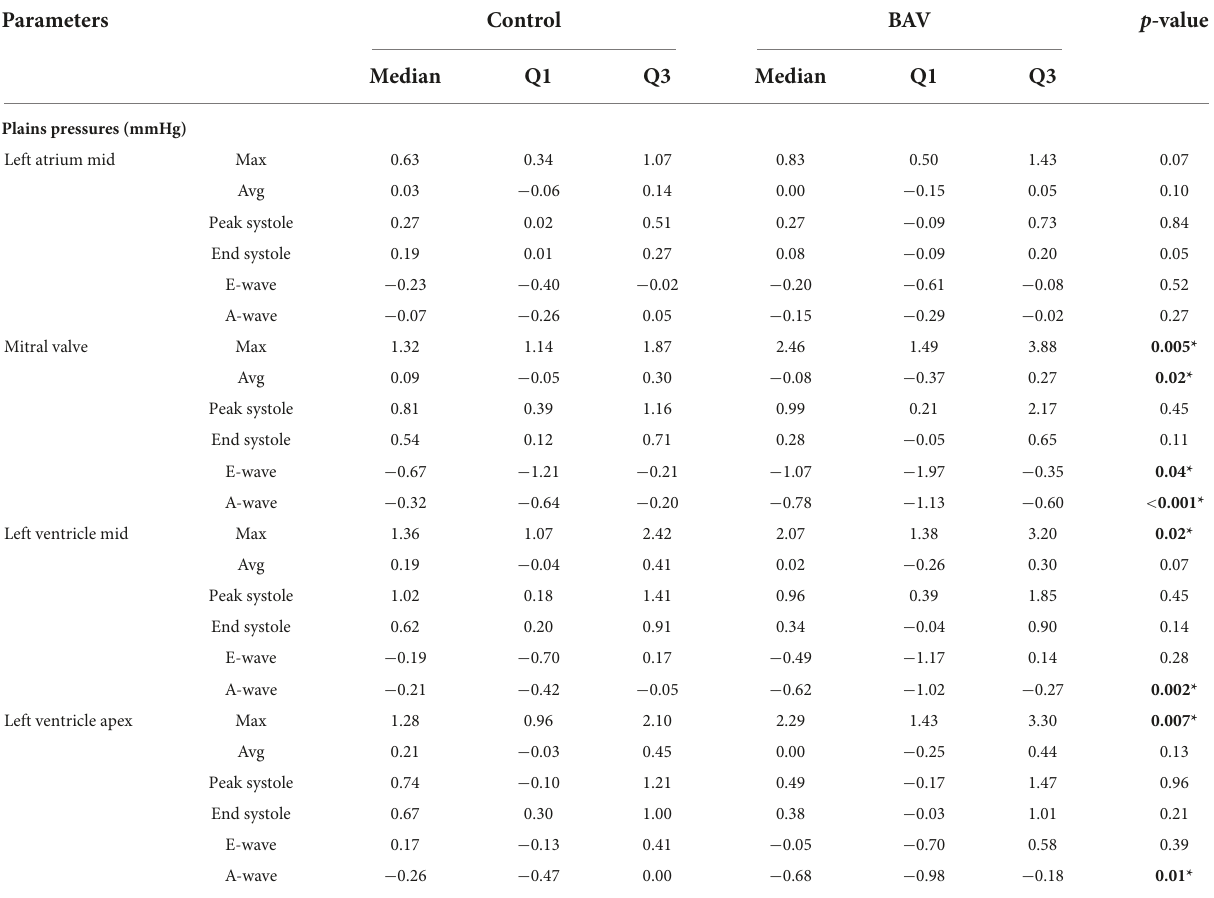
TABLE 3 Pressure